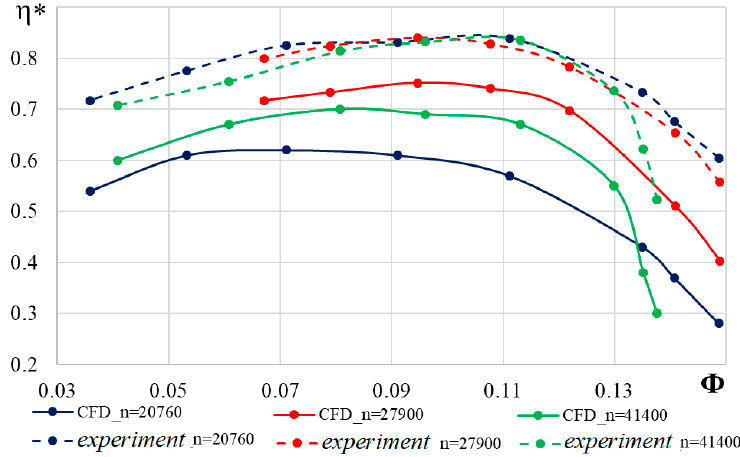
Figure 14. Characteristics of the polytropic efficiency of TKR 140E versus the flow rate coefficient.